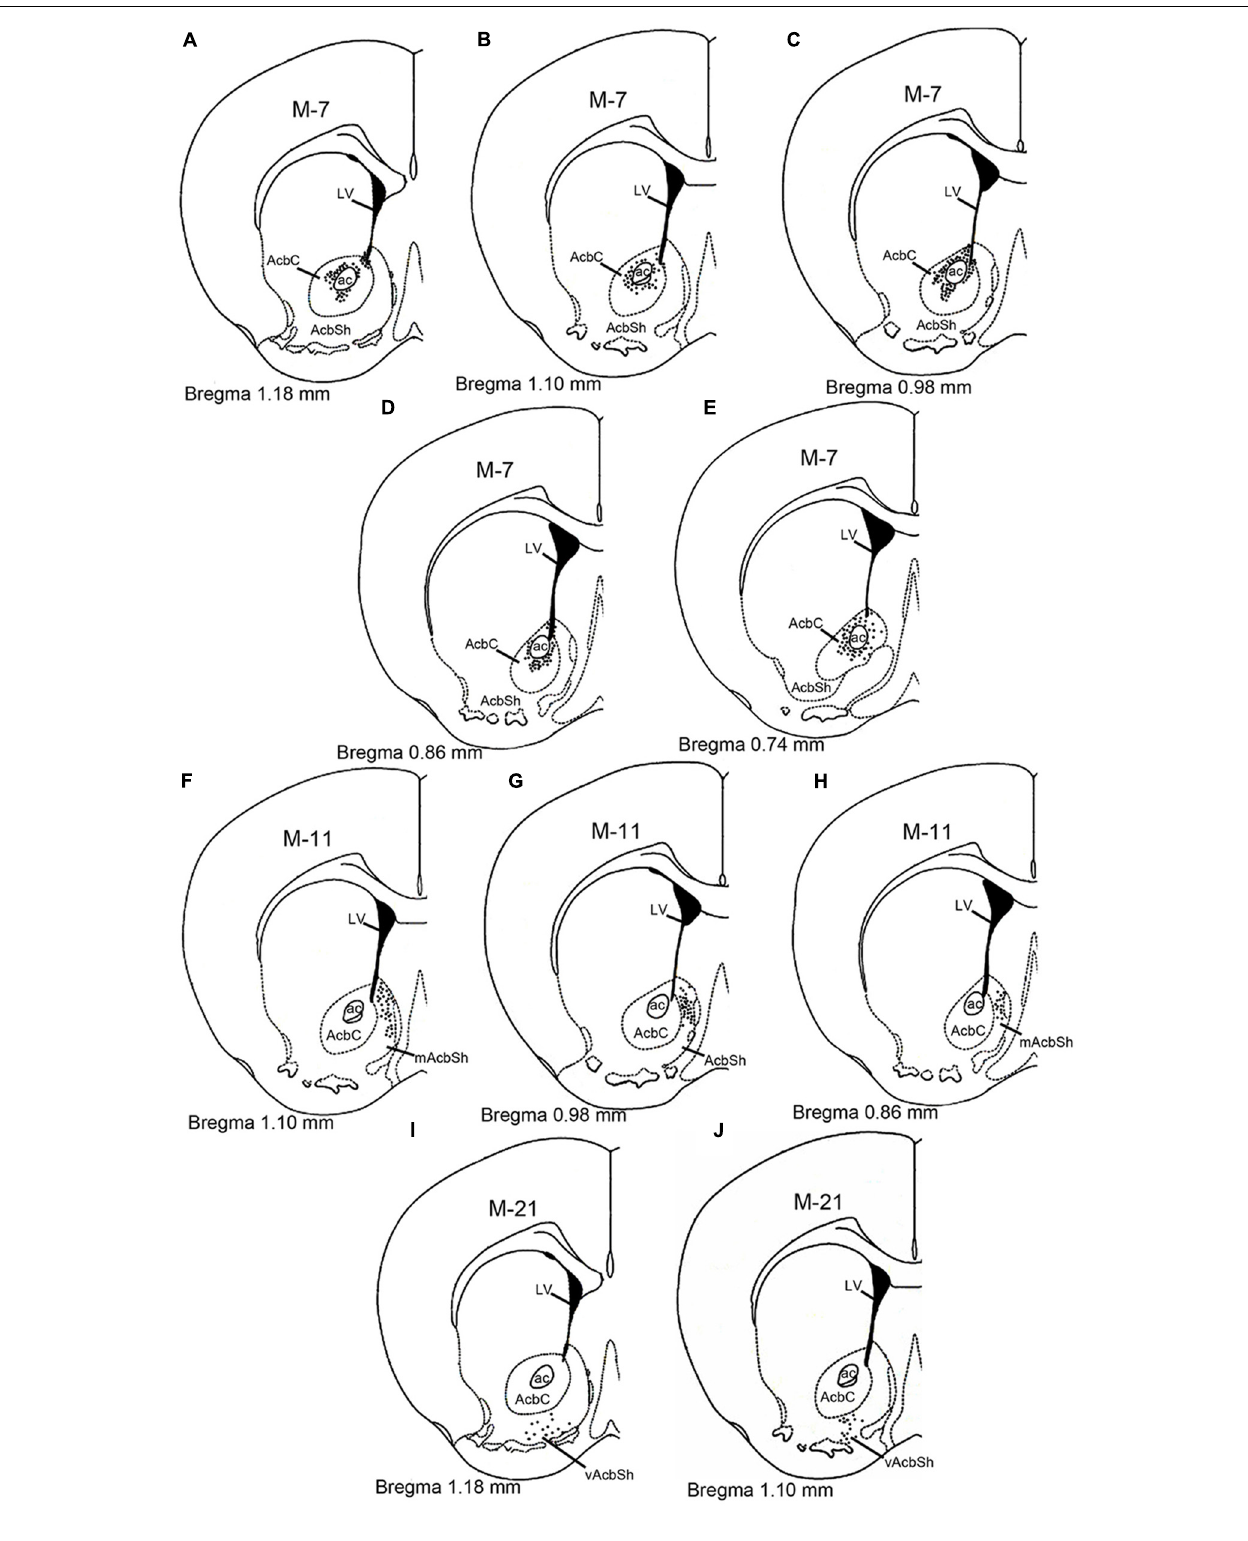
FIGURE 1 | Schematic diagram showing the AAV-lox-Stop-hrGFP injection sites in the nucleus accumbens. The dotted areas indicate the injection locations in the core (A–E) , medial shell (F–H) , and ventral shell (I–J) . Each dark dot represents one labeled